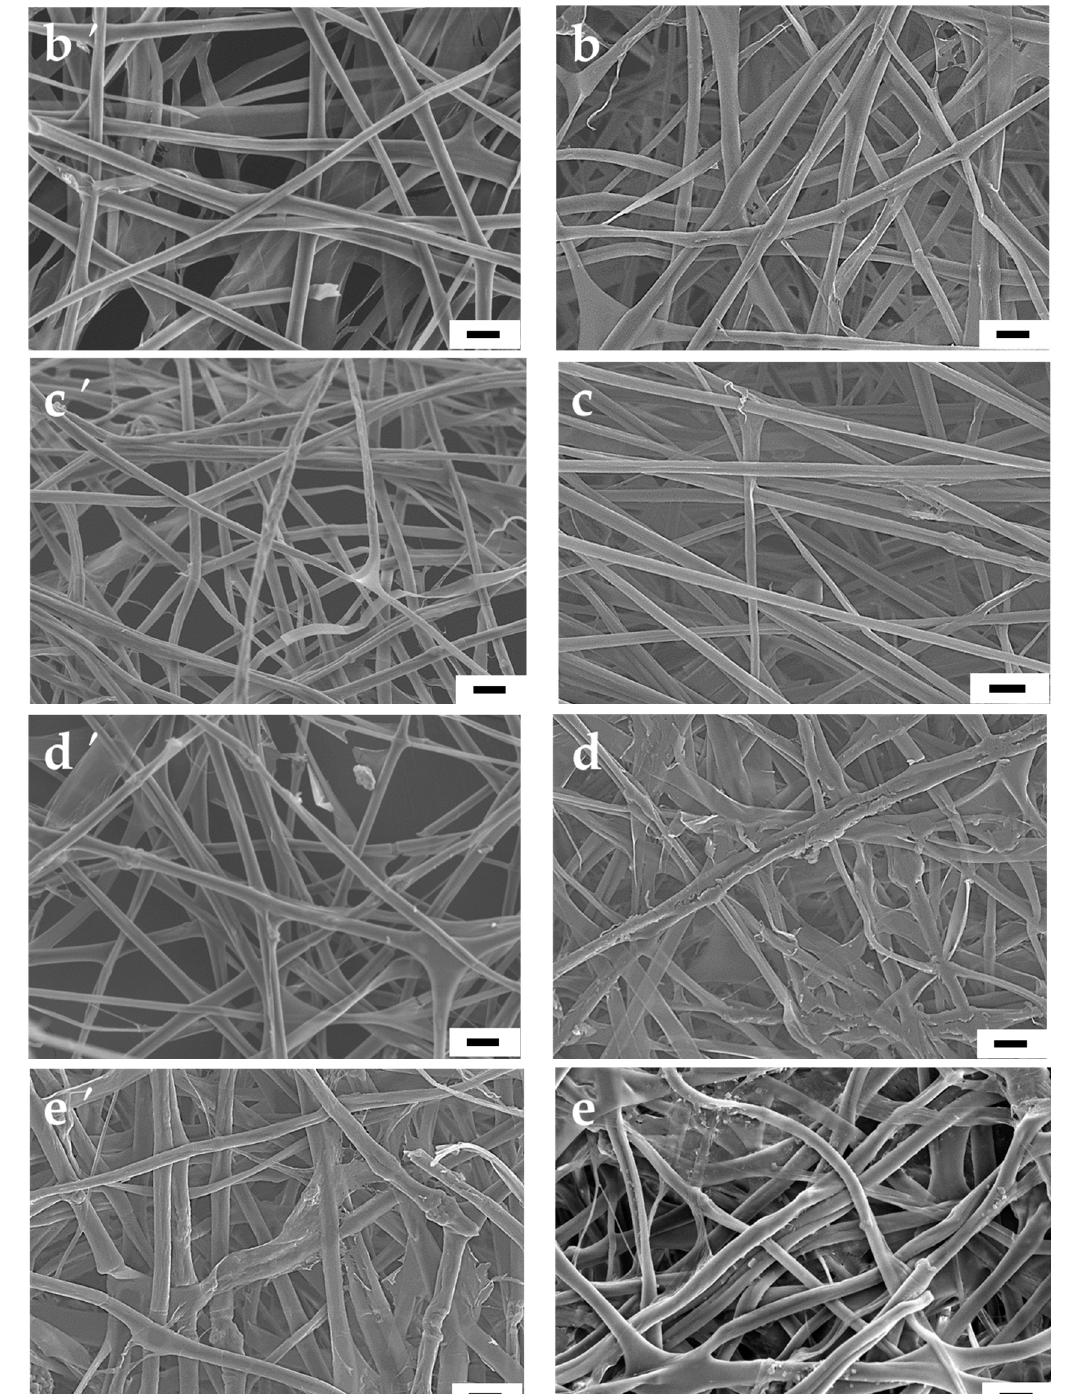
Figure 1. Field emission scanning electron microscope (FESEM) images of S0 ′ ( a ′ ), S1 ′ ( b ′ ), S2 ′ ( c ′ ), S3 ′ ( d ′ ) and S4 ′ ( e ′ ); S0 ( a ), S1 ( b ), S2 ( c ), S3 ( d ) and S4 ( e ) (the scale bar is 10 μ M).